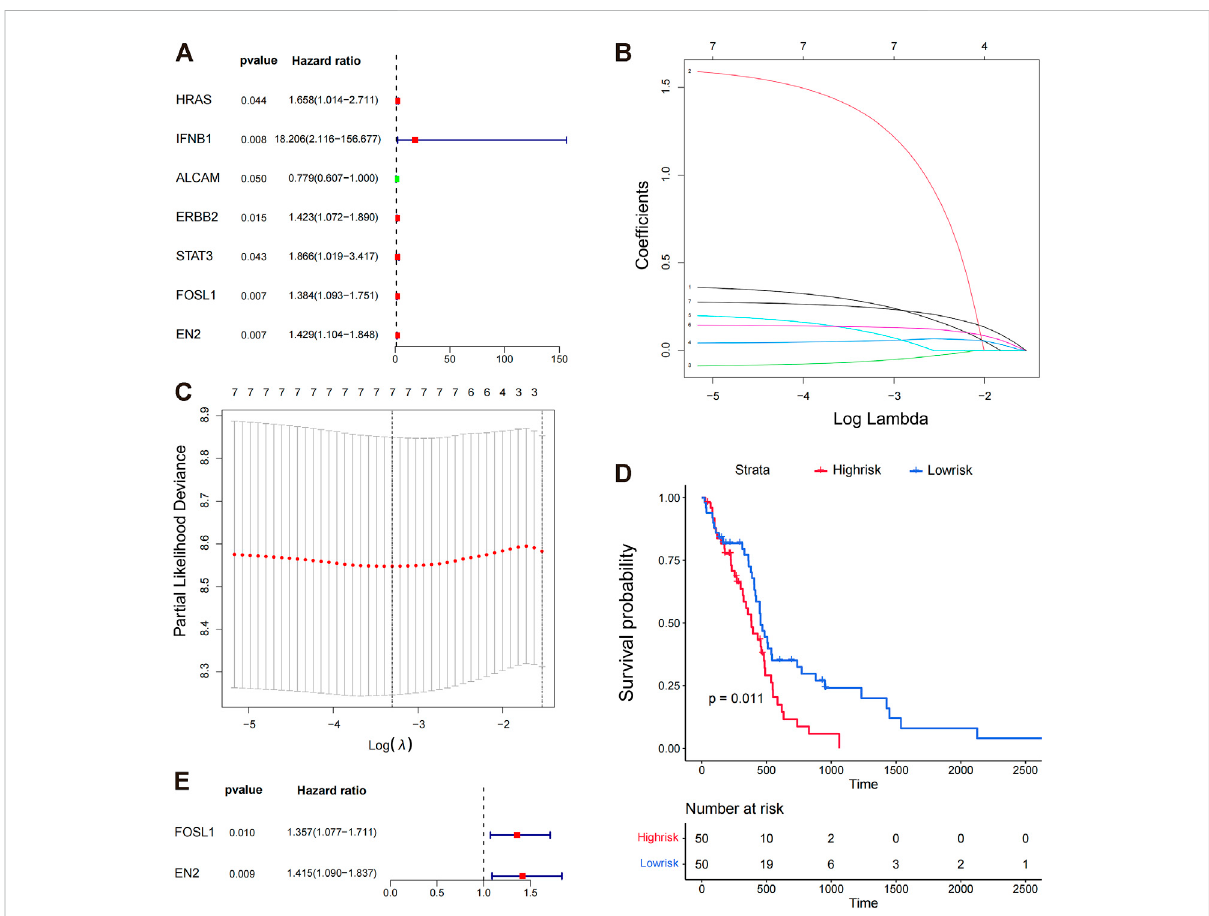
FIGURE 3 PrognosticvalueofmiRNAtargetgenes. (A) Genestargetedbysigni fi cantmiRNAswereanalyzedbyunivariateCoxproportionalriskregression. (B,C) Lasso regression analysis was conducted on the seven target genes screened by univariate Cox proportional risk regression analysis, and the seven best genes were screened again by Lasso regression. (D) K – M plots show the survival differences between high- and low-risk groups in the training set samples. (E) Survival risk regression model was constructed using multi-factor Cox proportional risk regression and stepwise regression, and two genes were retained, FOSL1 and